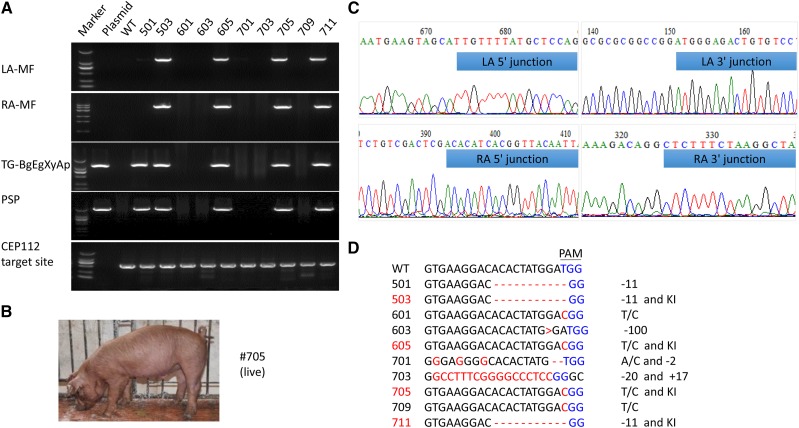
Generation of cloned pigs by using CRISPR/Cas9-mediated HDR system. (a) Genomic DNA of the cloned pigs was amplified by PCR and analyzed by gel electrophoresis. (b) The live KI pig (705) aged 1 month. (c) PCR products of KI loci were sequenced. Blue represents the junction sequences of the HAs and KI locus. (d) Sequences of the targeted CEP112 loci of all cloned pigs. KI pigs are shown with red numbers. Red letters and dashes represent indels. PAM sequence is displayed in blue.